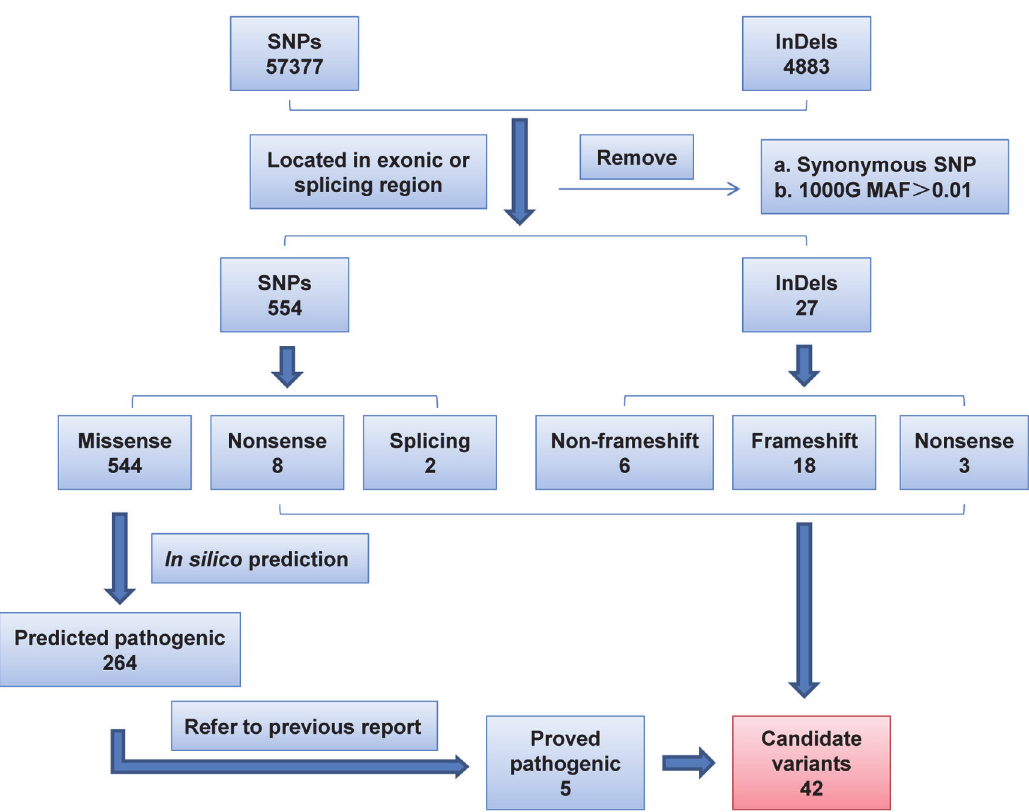
Fig 2. Filtering of variants. Detailed procedure was described in Materials and Methods . The URLs for the locus-specific databases used were as follows: BRCA1/2 , http://research.nhgri.nih.gov/bic/; TP53 , http://www-p53.iarc.fr/; DNA MMR genes, http://www.insight-group.org/.